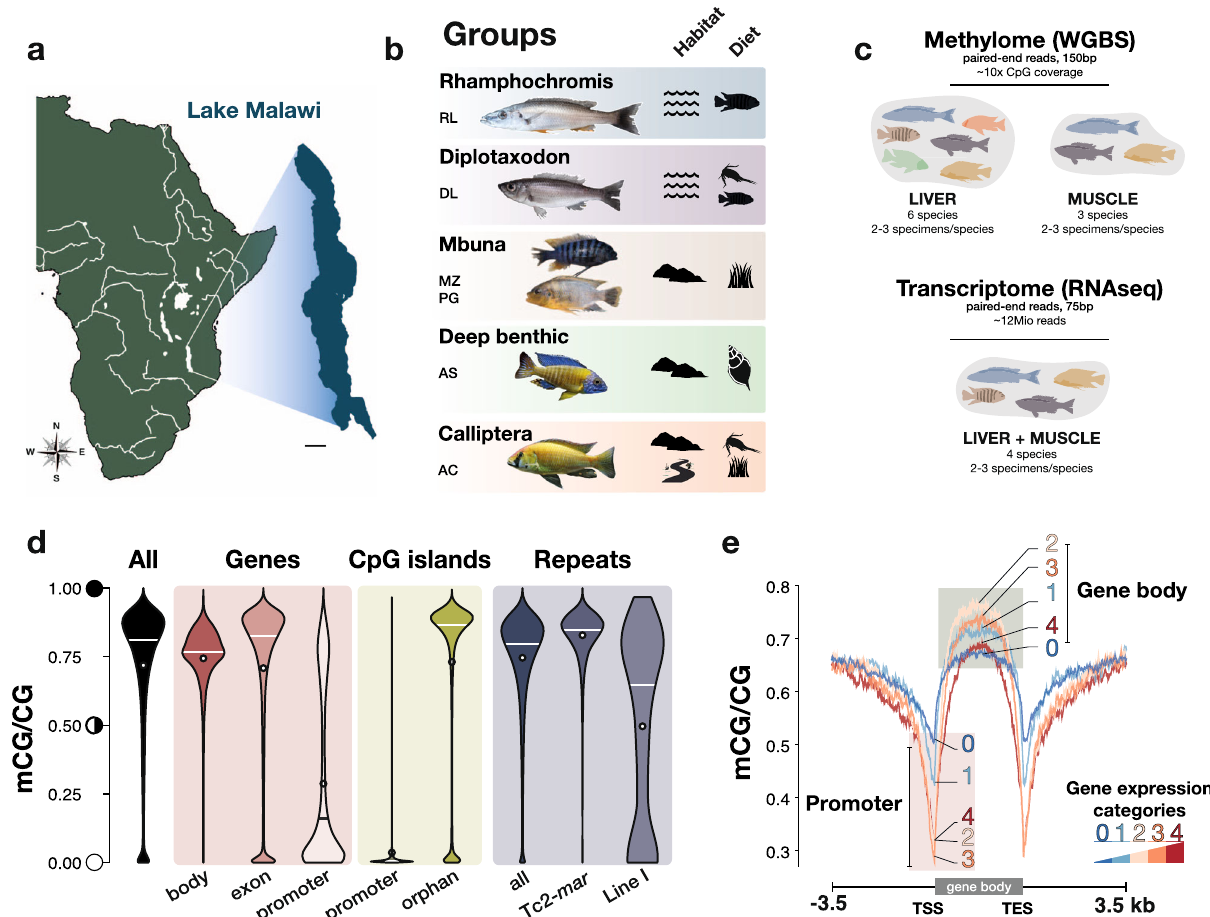
Fig. 1 The methylome of Lake Malawi cichlids. a Map of Africa (main river systems are highlighted in white) and magni fi cation of Lake Malawi (scale bar: 40 km). b Photographs (not to scale) of the six Lake Malawi cichlid species part of this study spanning fi ve of the seven described eco-morphological groups. The symbols represent the different habitats (pelagic/benthic [wave symbol], rock/sand-dwelling/littoral [rock symbol] and adjacent rivers part of Lake Malawi catchment), and the type of diet ( fi sh, fi sh/zooplankton, algae, invertebrates) for each group. The species representing each group are indicated by their initials (see below). c Diagram summarising the sampling and sequencing strategies for liver and muscle methylome (whole-genome bisul fi te sequencing, WGBS) and whole transcriptome (RNAseq) datasets. See “ Methods ” , Supplementary Fig. 1 and Supplementary Table 1. d Violin plots showing the distribution of liver DNA methylation levels in CG sequence context (averaged mCG/CG levels over 50 bp-long bins genome-wide) in different genomic regions: overall, gene bodies, exons, promoter regions (TSS ± 500 bp), CpG-islands in promoters and outside (orphan) and in repeat/ transposon regions. mC levels for two different repeat classes are given: DNA transposon superfamily Tc2-Mariner ( n = 5,378) and LINE I ( n = 407). e Average liver mCG pro fi les across genes differ depending on their transcriptional activity in liver: from non-expressed (0) to genes showing low (1), intermediate (2), high (3) and highest (4) expression levels ( “ Methods ” ). Results shown in ( d, e ) are for Mbuna MZ (liver, n = 3) and are representative of the results for all other species, and are based on average mC/C in 50 bp non-overlapping windows. RL, Rhamphochromis longiceps; DL, Diplotaxodon limnothrissa; MZ, Maylandia zebra; PG, Petrotilapia genalutea; AS, Aulonocara stuartgranti; AC, Astatotilapia calliptera . Credits — Fish photographs: Hannes Svardal and M. Emília Santos. Geographical map modi fi ed from